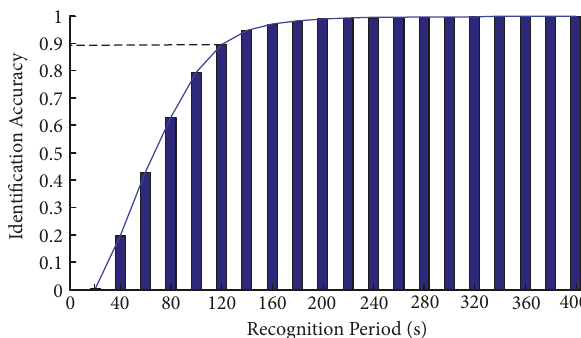
Figure 10: The identification accuracy in different identification periods.